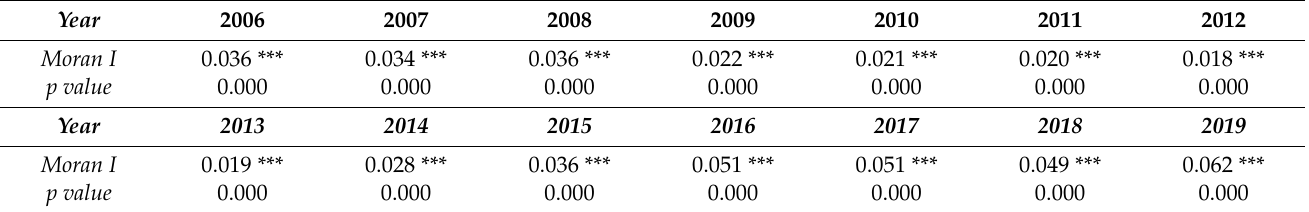
Table 11. 2006–2019 China Carbon Emission Efficiency Global Moran Index.